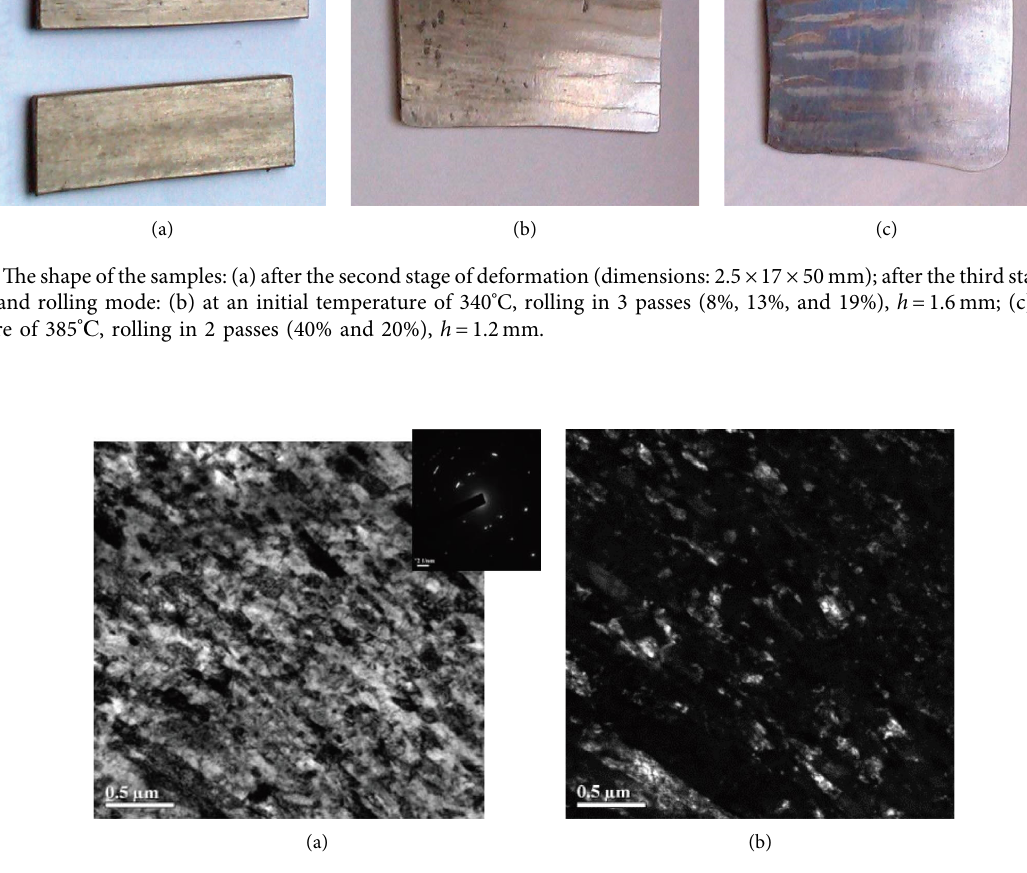
Figure 12: Microstructure of the rolled billet after the third stage of deformation (heating 340 ° C, cross rolling of the sample, h � 1.6mm): (a) bright-feld image and microdifraction; (b) darkfeld image.